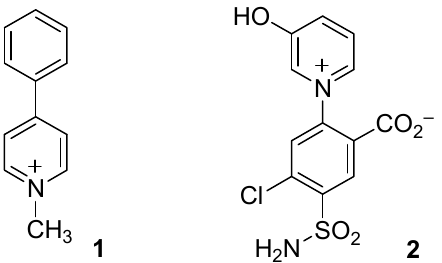
Scheme 1. Structure of 1-methyl-4-phenylpyridinium (MPP+) 1 and pyridinium furosemide 2 correlated to